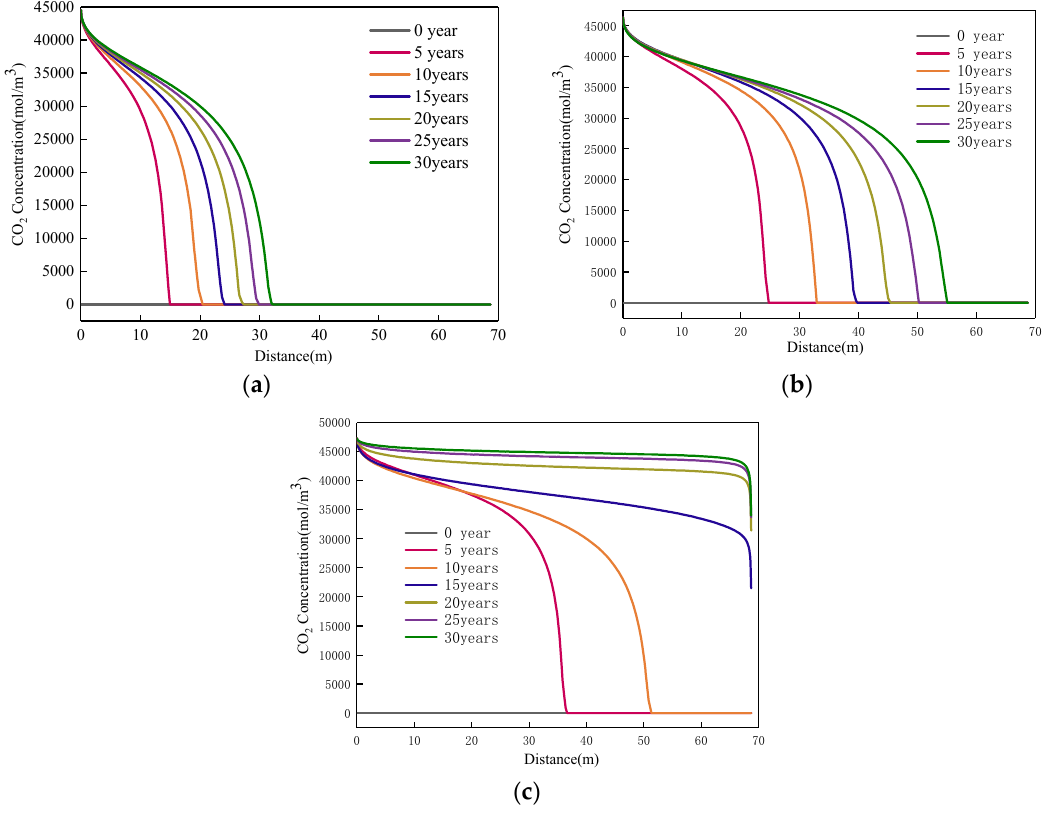
Figure 5. Distribution of diagonal CO 2 molar concentrations at different injection pressures: ( a ) injection pressures is 4 MPa; ( b ) injection pressures is 6 MPa; and ( c ) injection pressures is 8 MPa.